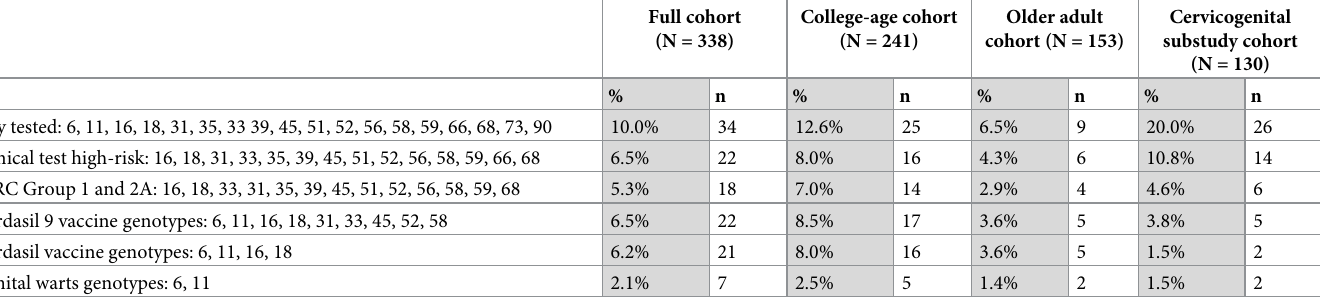
Table 2. HPV prevalence in the oral cavity (valid tests at baseline) or cervicovaginal canal (at first valid test) in the MHOC study by genotype classification (data collected in Ann Arbor, MI, 2015–17, analyzed